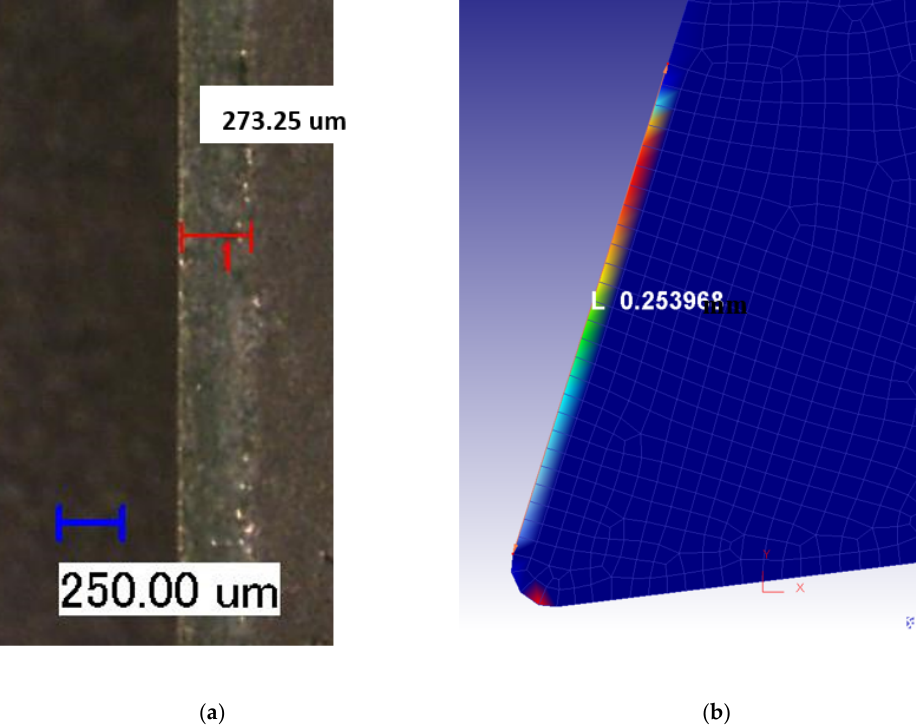
Figure 18. Crater wear for dry mode: ( a ) experimentally observed and ( b ) FE-simulated.